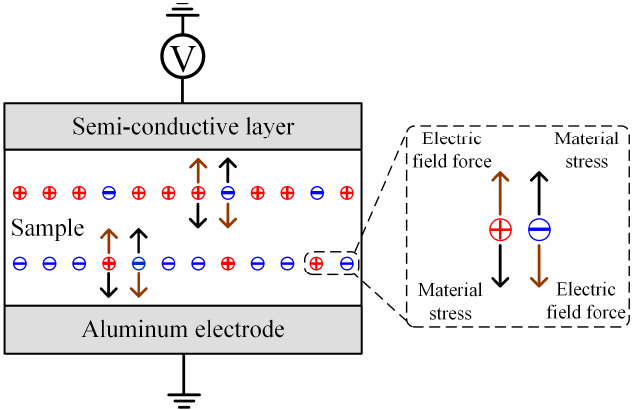
Figure 11. The forces withstood by the migrating space charge.